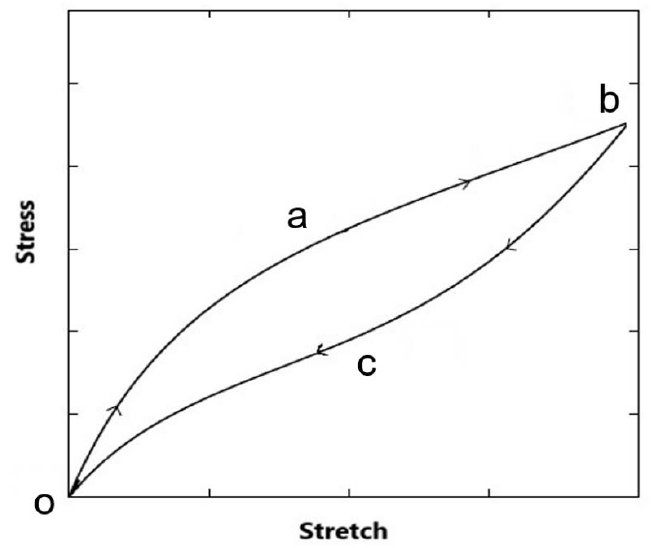
Figure 2. Stress-stretch behavior with hysteresis under simple tension.